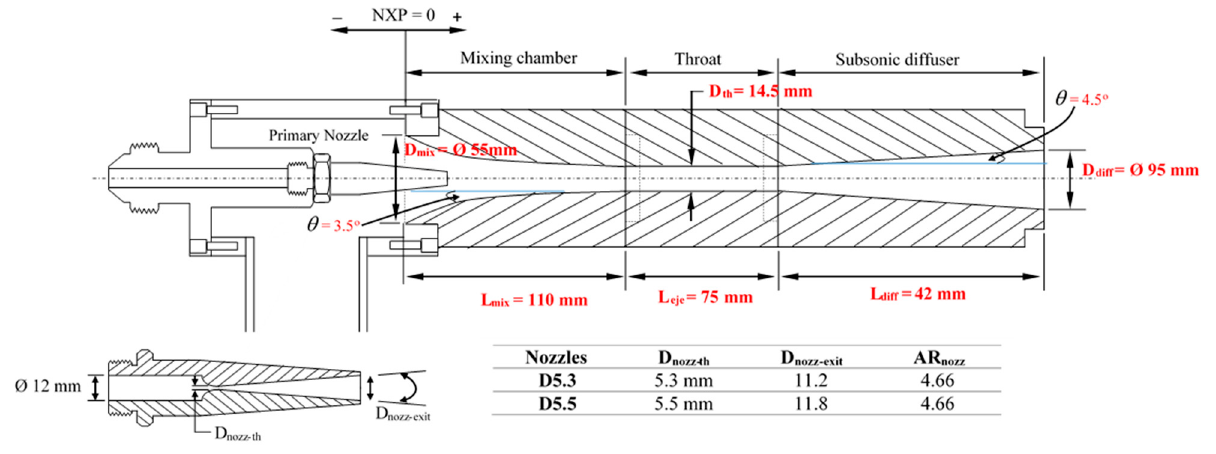
Figure 4. The geometrical drawing of the ejector and primary nozzles.